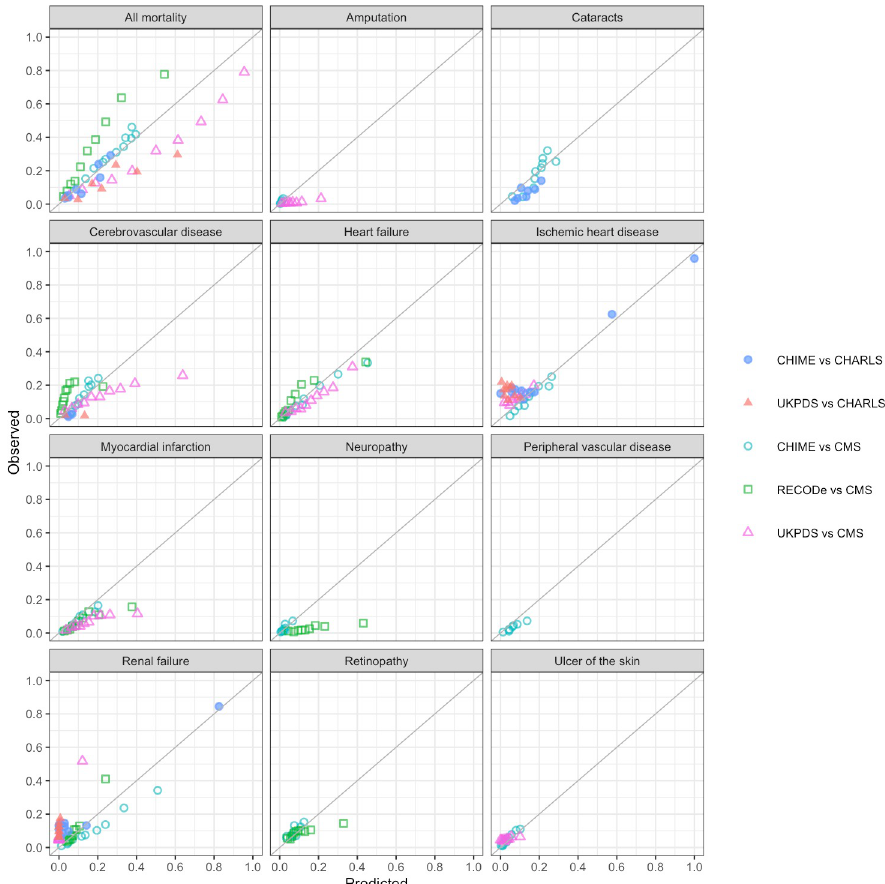
Fig 2. Calibration plots of CHIME, UKPDS-OM2, and RECODe model for diabetes. Predictions using CHIME, UKPDS-OM2, and RECODe are presented if available. Points are displayed for deciles of predicted and observed event rates, with fewer centiles than deciles used if fewer than 5 events were observed per group to prevent unstable inferences. CHARLS, China Health and Retirement Longitudinal Study; CHIME, Chinese Hong Kong Integrated Modeling and Evaluation; CMS, Clinical Management System; RECODe, Risk Equations for Complications Of type 2 Diabetes; UKPDS-OM2, United Kingdom Prospective Diabetes Study Outcomes Model